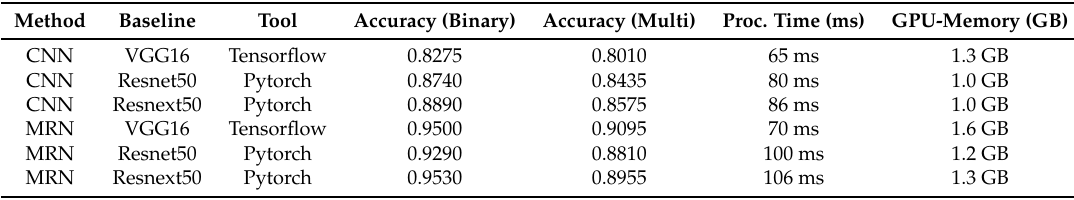
Table 2. Effects on the accuracy for different baseline